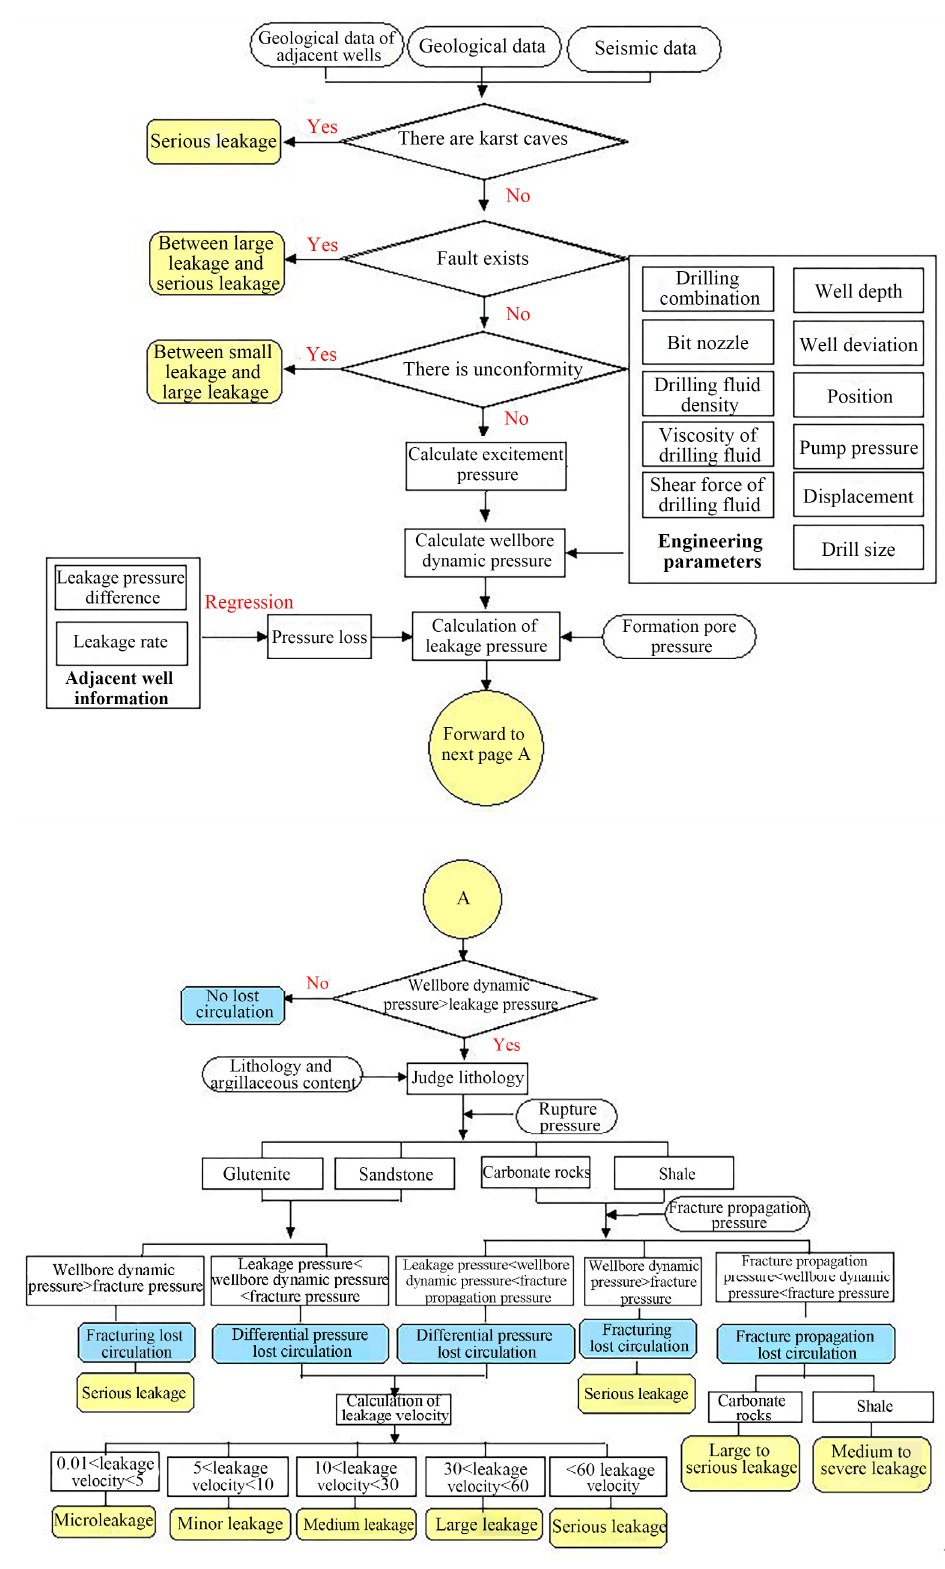
Figure 8. Permeability leakage warning model.